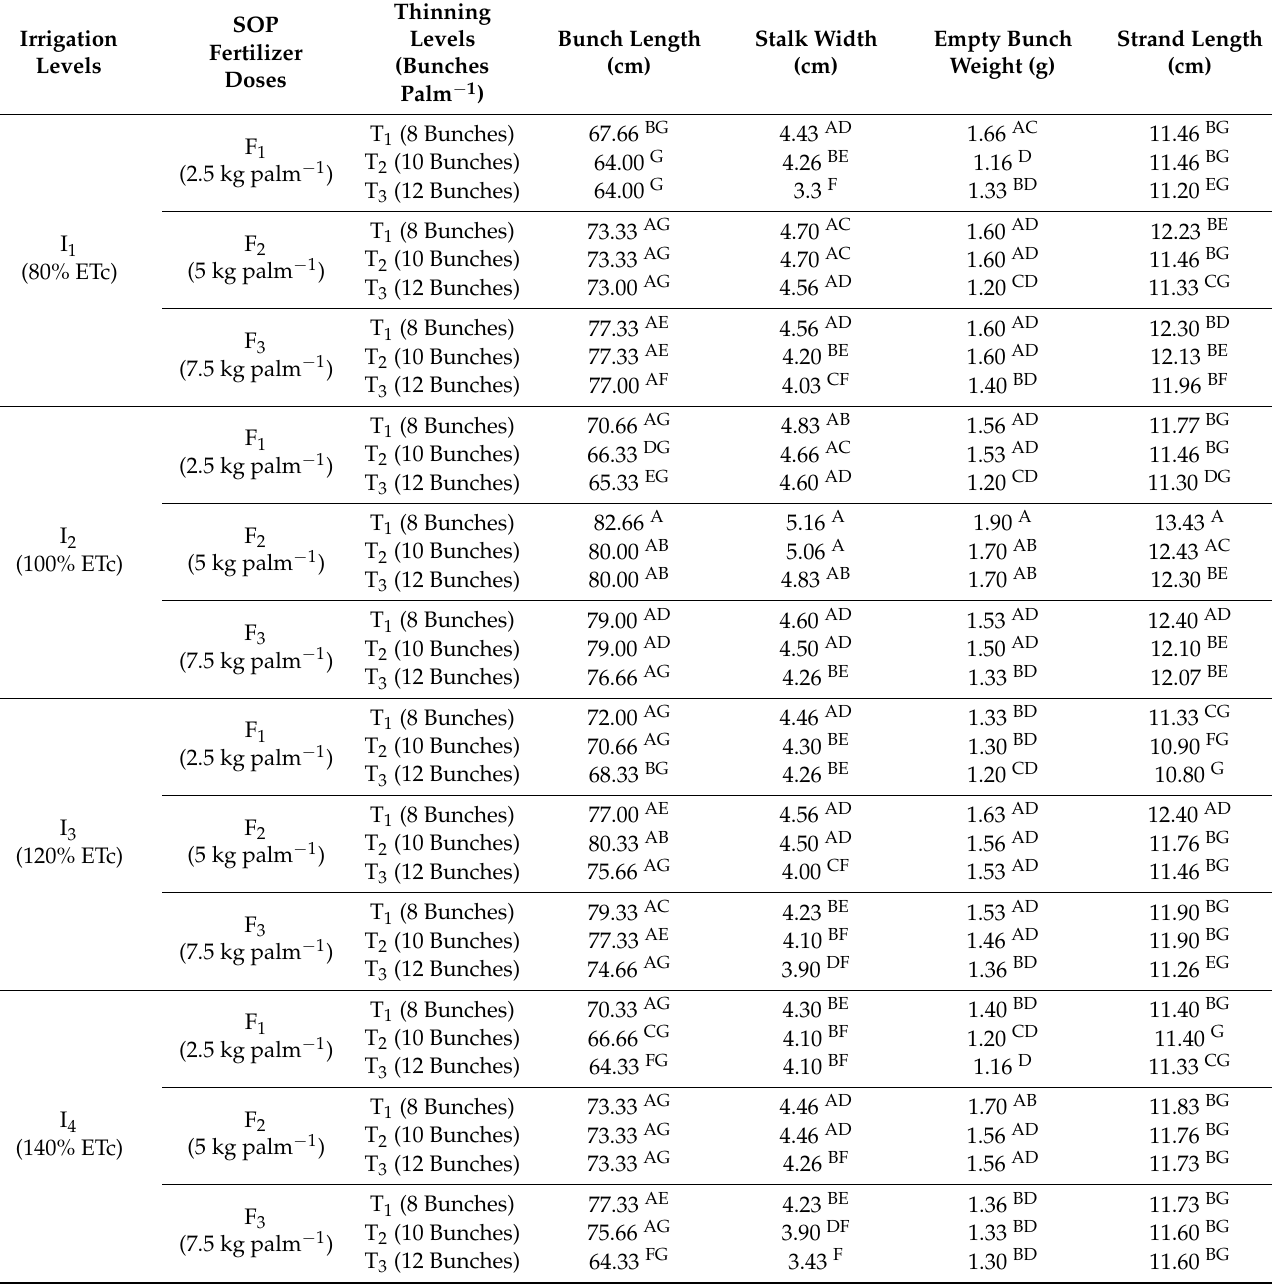
Table 1. Effects of irrigation levels, SOP fertilizer doses, and bunch thinning levels on the bunch length, stalk width, empty bunch weight, and strand length of date palm cv. Sukary. Each mean data represents the averages from two seasons